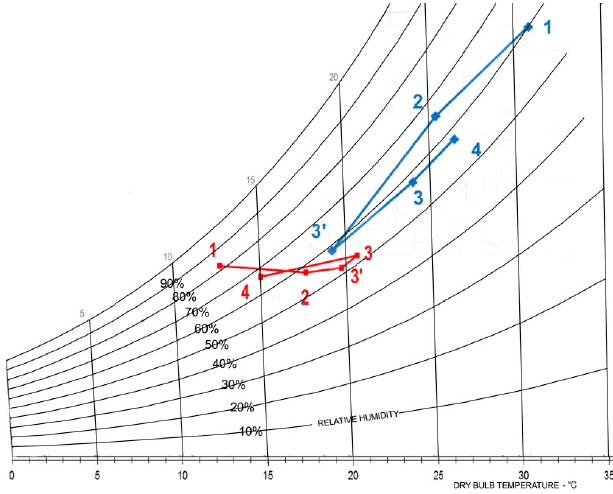
Figure 13. Psychrometric chart—thermodynamic transforms: (red lines) “Heating”—22 April at 12 p.m.—and (blue lines) “Cooling”—3 July at 12 p.m.